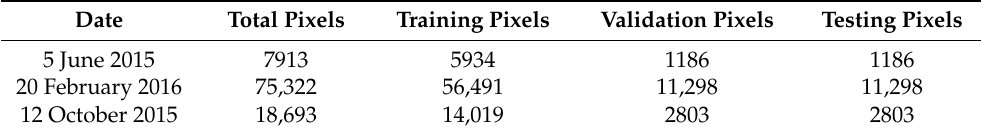
Table 8. Rain rate estimation dataset-night-time.